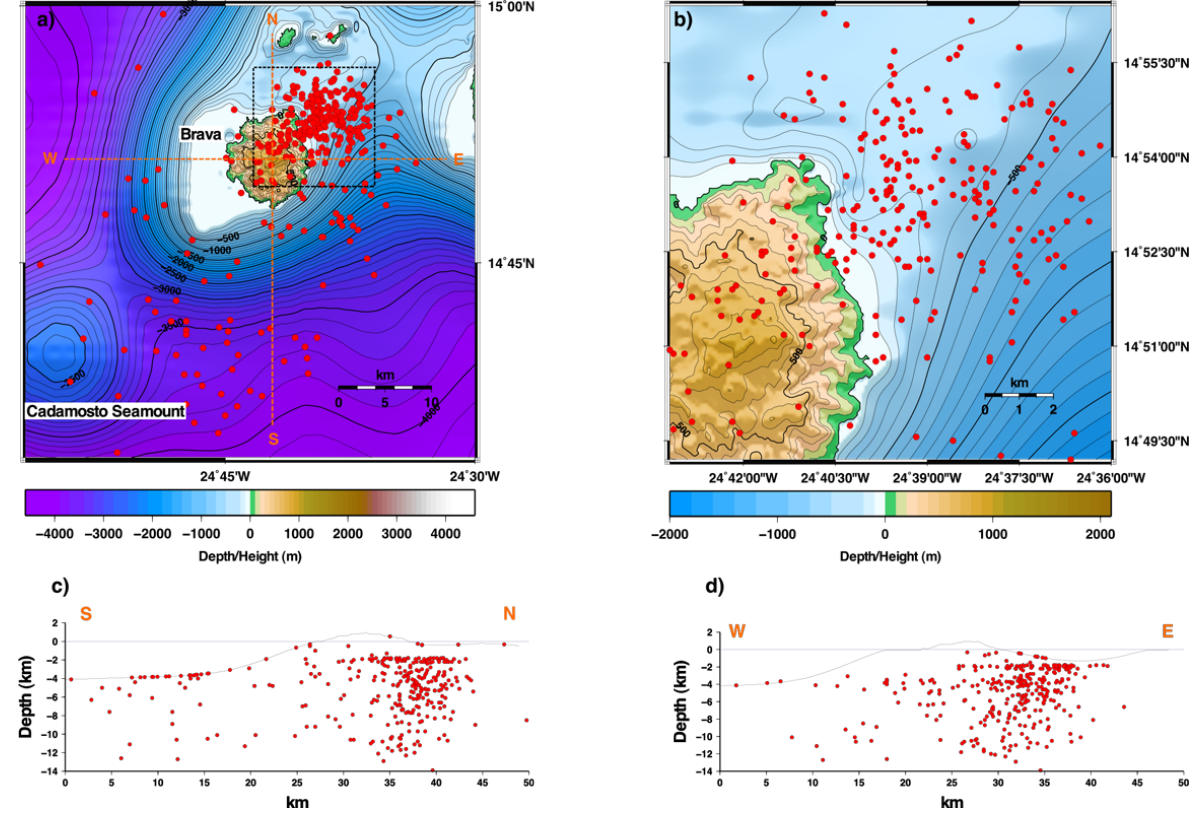
Fig. 10. (a) Epicentral geographic distribution (red dots) of the seismic events recorded in or near Brava between September 2011 and May 2013, as well as the bathymetry (contour interval 100m). (b) A detailed view of seismic events around the NE of Brava (inset box from a ). (c) Hypocentres projected on a section parallel to the S–N direction. (d) Hypocentres projected on a section parallel to the W–E direction.